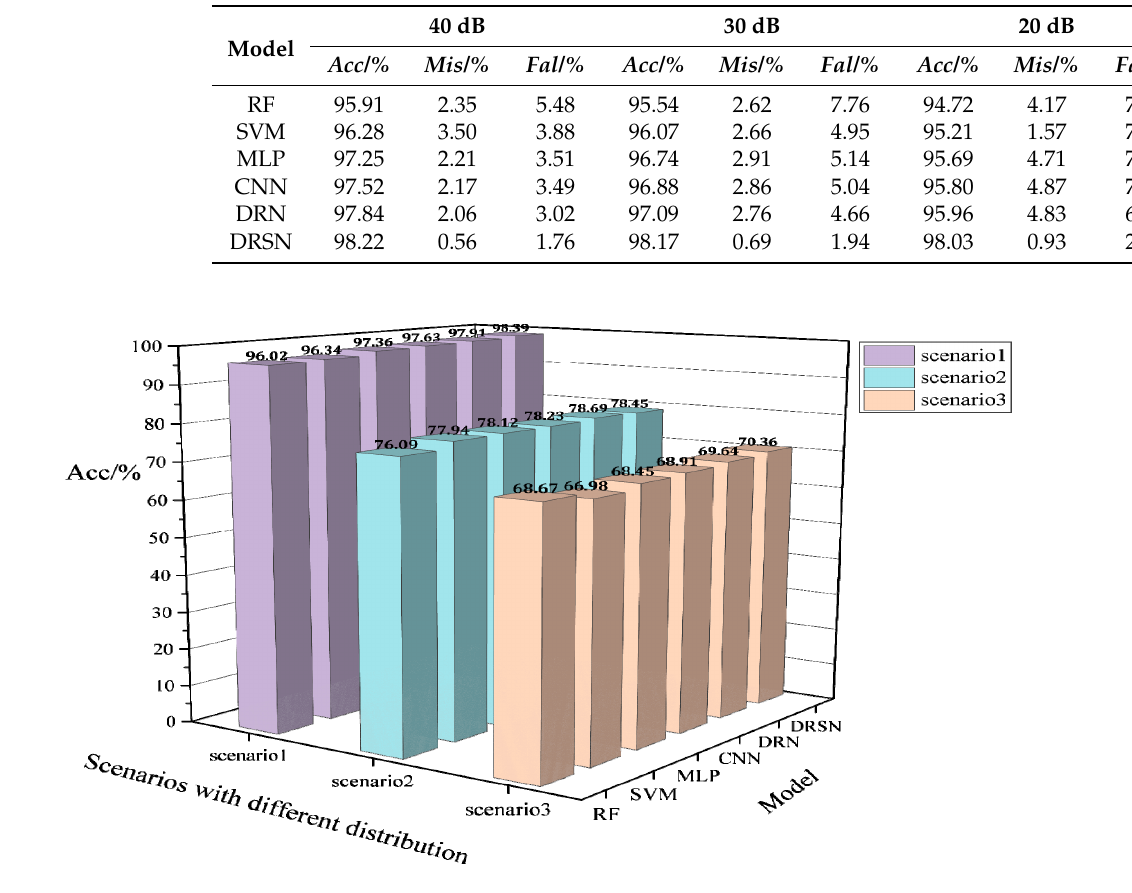
Figure 11. Acc performance of different models trained on the IEEE 118-bus system based on the fixed distribution for a new scenario with large disturbances.